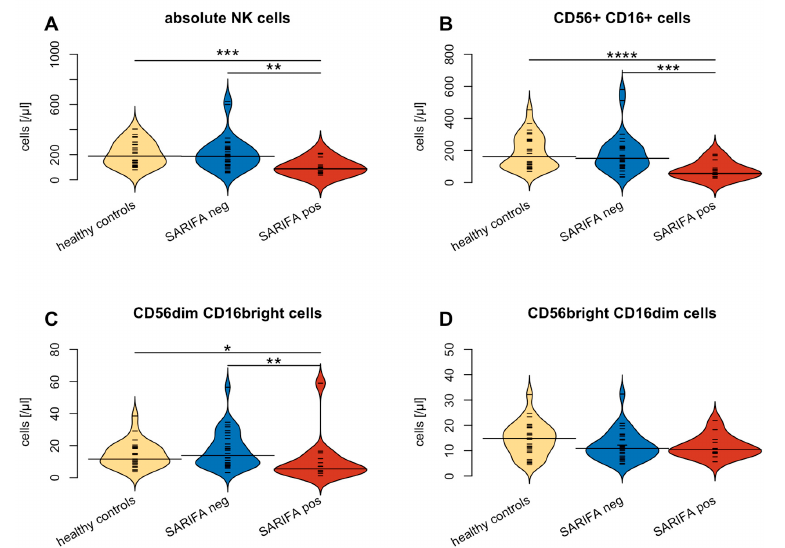
Figure 3. Comparison of NK cells in general ( A ) and CD56+ CD16+ subtype ( B ) as well as between CD56dim CD16bright ( C ) and CD56bright CD16dim ( D ) NK cell subtypes between healthy controls (yellow), SARIFA-pos(itive) (red) and SARIFA-neg(ative) (blue) CRC patients. Small white lines indicate individual data points; large black lines show the overall subset average of SARIFA-positive and SARIFA-negative CRC patients, respectively. * p < 0.05, ** p < 0.01, *** p < 0.001, **** p < 0.0001. Table 3. Lymphocyte subsets in healthy controls, SARIFA-positive and SARIFA-negative CRC pa- tients. healthy controls SARIFA-positive SARIFA-negative n = 27 n = 15 n = 30